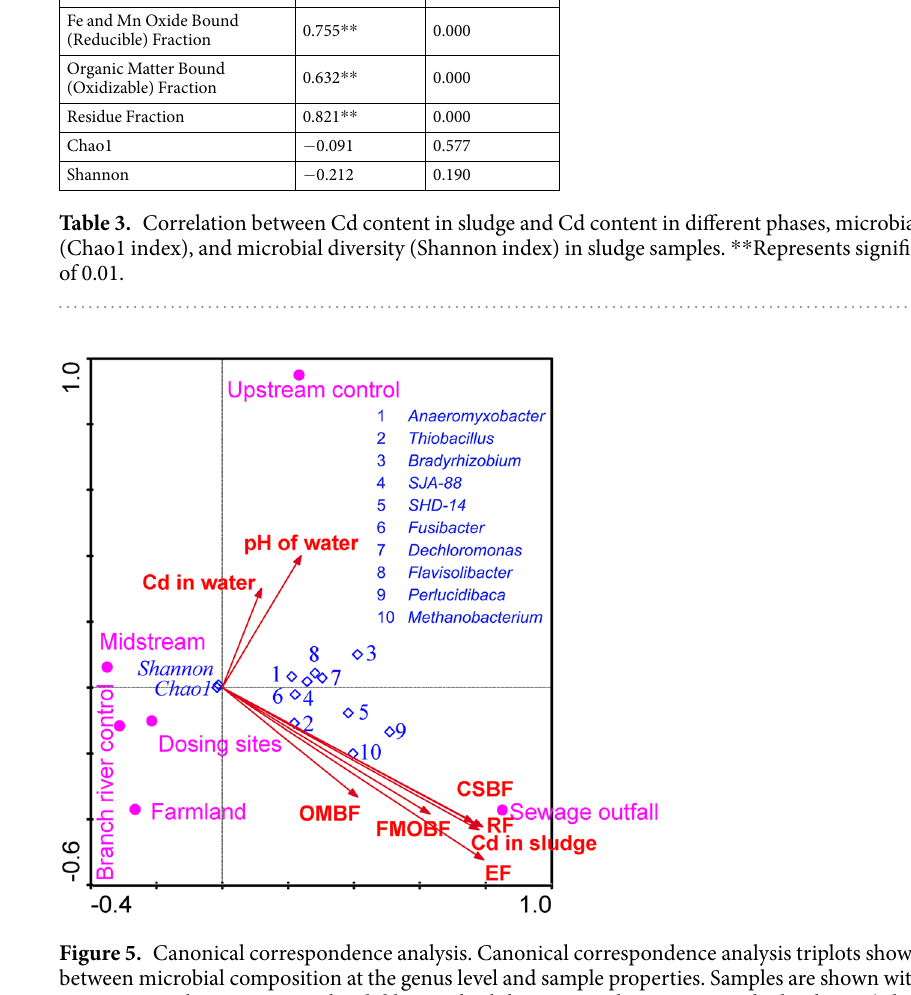
samples were separated in the tree. Microbial community composition exhibited regular changes with Cd content in different groups (Fig. 4). In all 73 phyla, the relative abundances of 29 phyla increased with the increase of Cd concentration, and the largest increase (TA06) was 5.42 times. In contrast, the abundances of 44 phyla decreased, and 3 phyla could not be even detected in the samples collected from high Cd concentration sites. Among them, 2 phyla (Gemmatimonadetes and Proteobacteria) had a significantly positive correlation and 10 phyla (GOUTA4, Fibrobacteres, Kazan-3B-28, WS2, WS4, OP8, KSB3, Planctomycetes, Chlamydiae and Caldiserica) had a signif- icantly negative correlation with Cd distribution (Table 2). On the genus level, 1273 genera were detected from all the groups. The relative abundances of 533 genera increased with the increase in Cd concentration. The largest increase ( Leucobacter ) was 8 times, while the abun- dances of 562 genera decreased. In particular, 178 genera were not present in the sewage outfall samples. Among them, the abundances of 39 genera (such as Pseudoxanthomonas , Halomonas , and Methanomassiliicoccus ) were positively correlated with the Cd distribution (p < 0.05), while those of 6 genera (such as C1_B004 , Clostridium , and vadinHB04 ) were negatively correlated with the Cd distribution (p < 0.05) (Table S2). Correlations between sample properties and microbial community composition. The relation- ships between environmental factors and microbial communities were evaluated by the canonical correspond- ence analysis (CCA) method (Fig. 5). All the environmental factors were distributed on the right side of the CCA